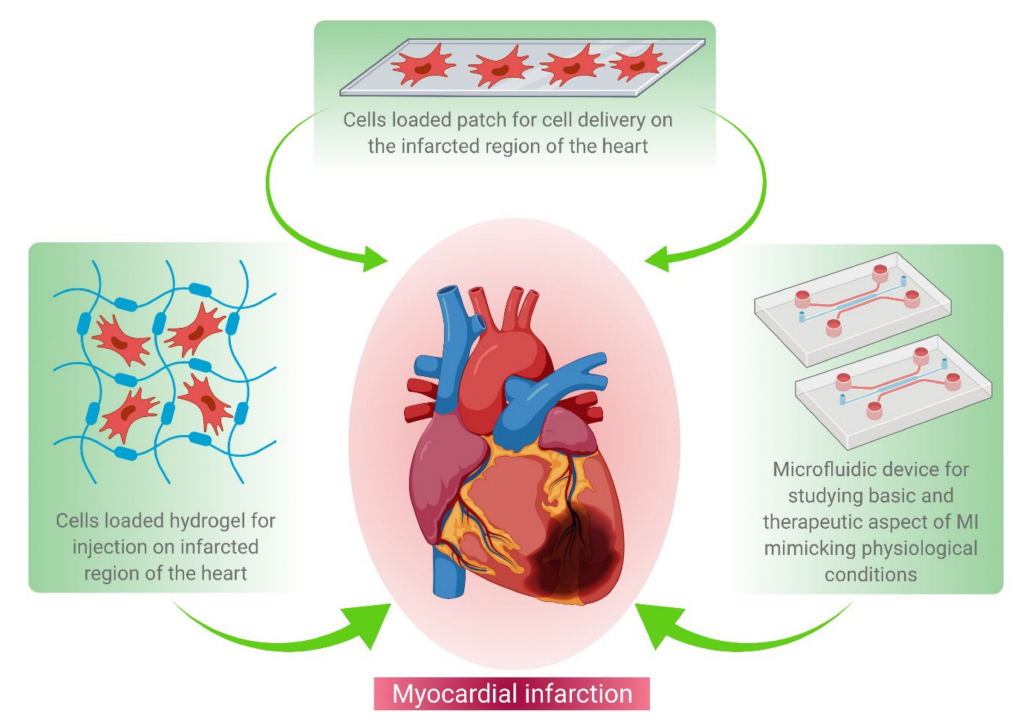
Figure 1. Schematic representation of various tissue engineering approaches for MI treatment. These approaches include hydrogel-based cell delivery (left hand corner), patch-based cell delivery (middle panel), and microfluidics-based drug screening (right corner) during the regenerative therapy of damaged heart